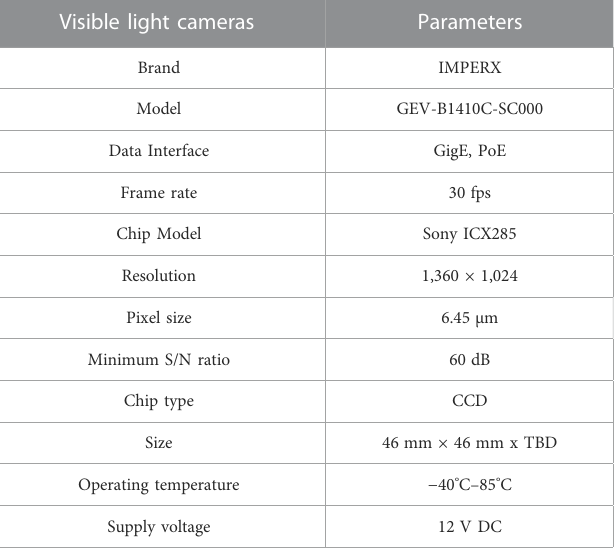
TABLE 1 Visible light camera Parameters. Visible light